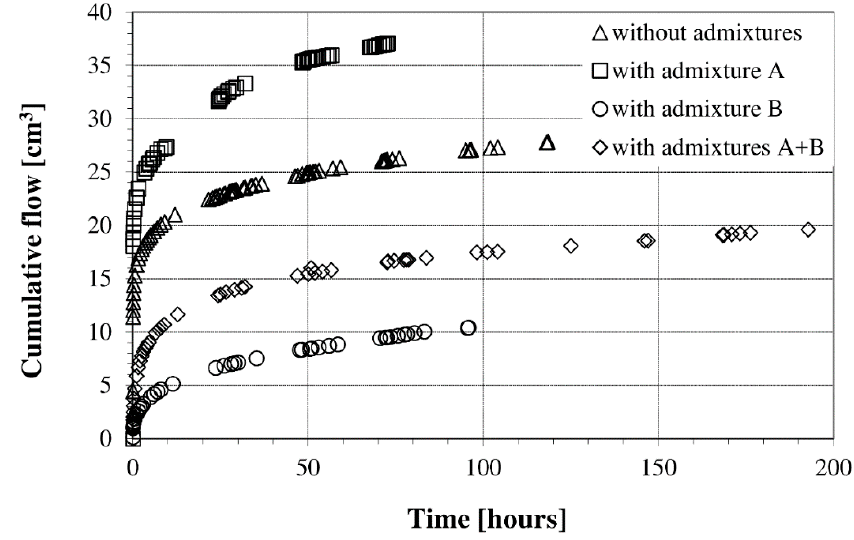
Figure 4. Dependence of the cumulative flow with the used admixtures at a pressure of 0.5 MPa.